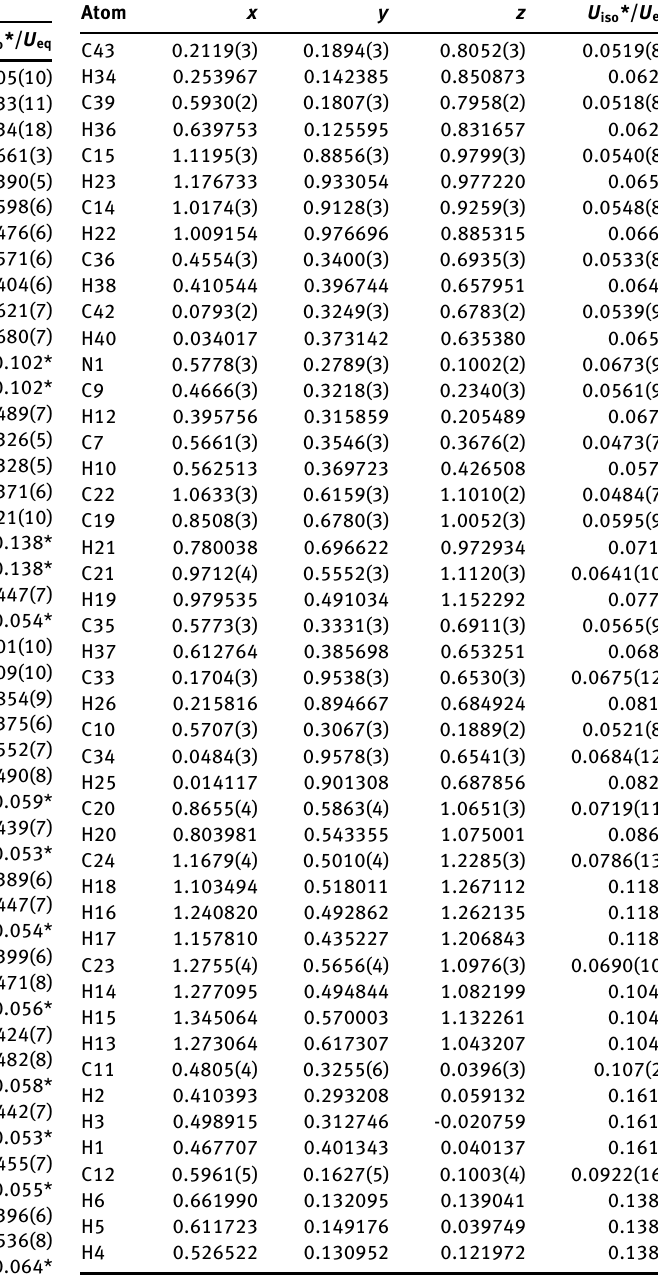
Table 2: Fractional atomic coordinates and isotropic or equivalent isotropic displacement parameters (Å 2